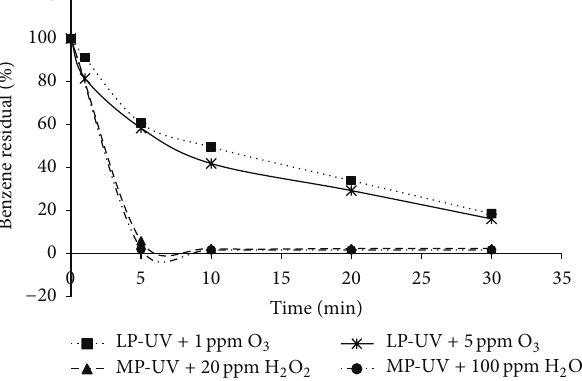
Figure 7: Removal of benzene using UV/O 3 process.